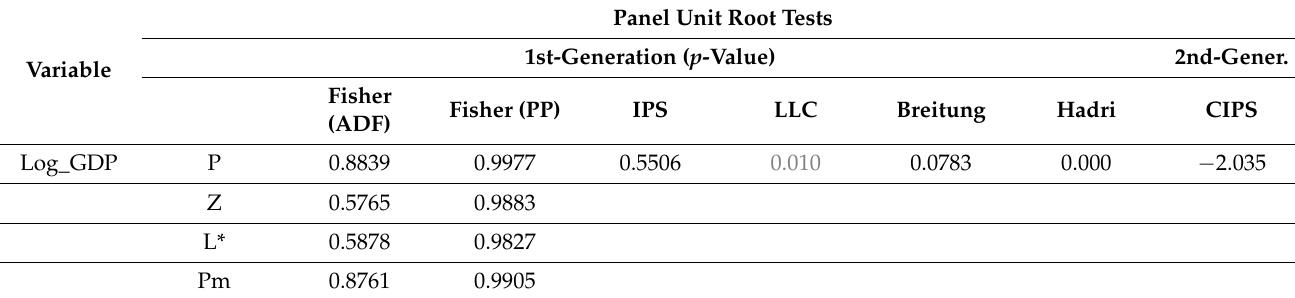
Table 2. Panel unit root